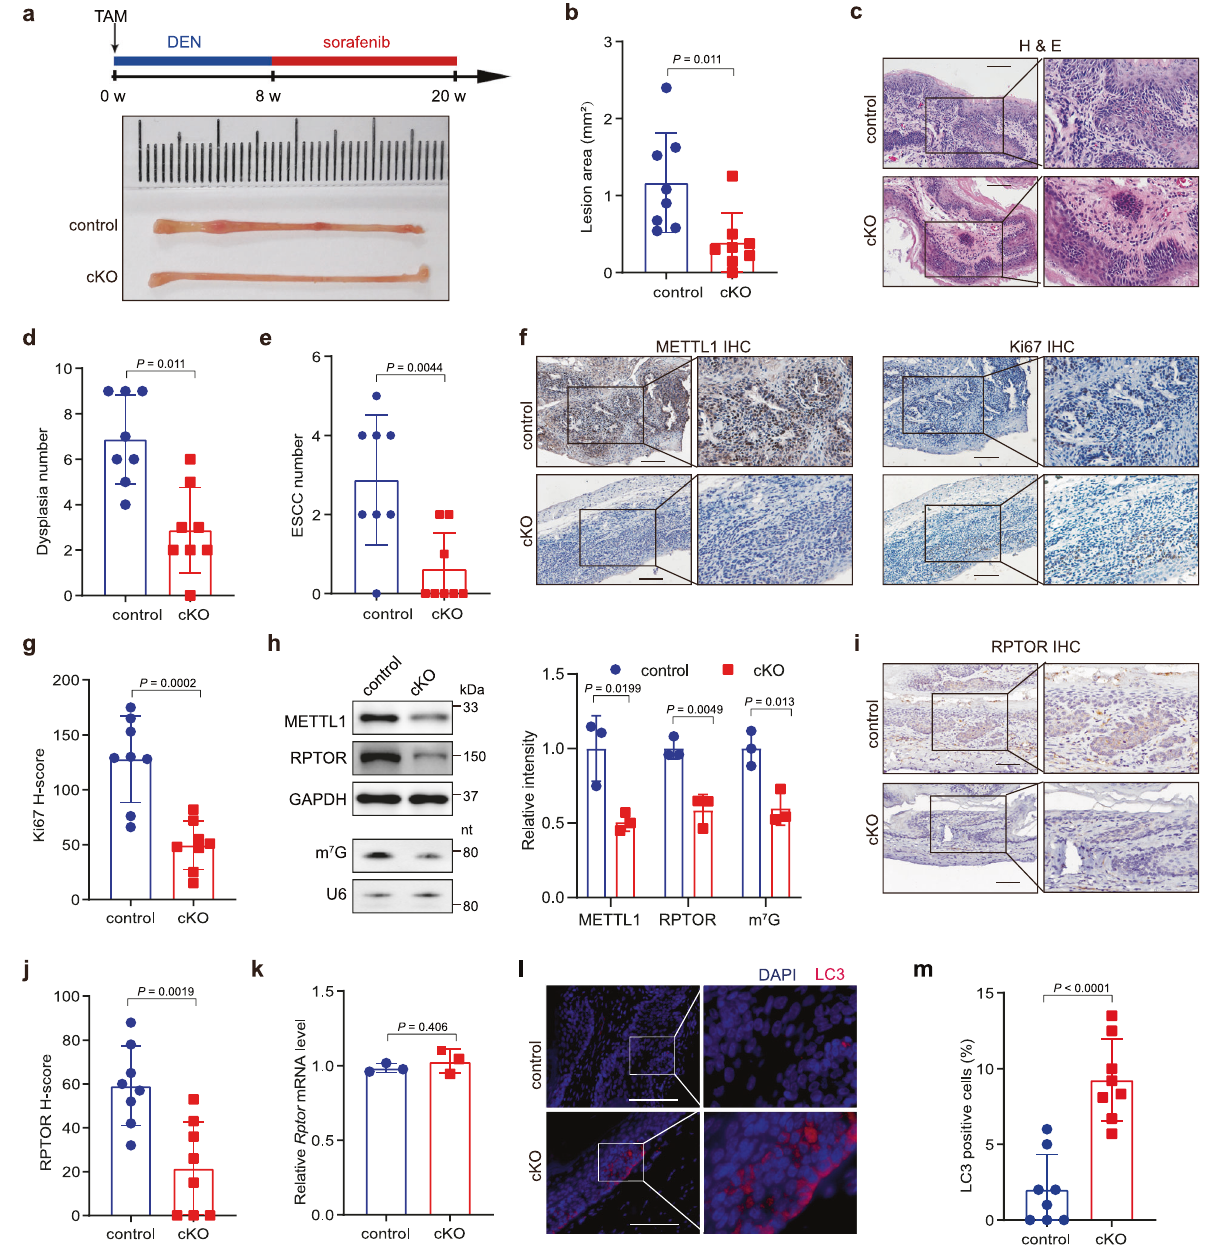
Fig. 5 Knockout of Mettl1 inhibits in vivo ESCC tumorigenesis. a Experimental design for ESCC tumorigenesis model and the representative images of esophageal lesions from Mettl1 cKO and control mice. b Quanti fi cation of lesion areas in Mettl1 cKO and control mice. c Representative H&E staining of esophagus tissues in Mettl1 cKO and control mice. Scale bar, 100 μ m. d Quanti fi cation of dysplasia numbers in Mettl1 cKO and control mice. e Quanti fi cation of ESCC numbers in Mettl1 cKO and control mice. f , g Representative images of METTL1 and Ki67 IHC staining ( f ) and the quanti fi cation of Ki67 H-scores ( g ) in Mettl1 cKO and control mice. Scale bar, 100 μ m. h Western blot analysis and northwestern blot analysis showed the m 7 G modi fi cation level and indicated protein levels, right panel: quanti fi cation of the blot signals, n = 3 biological independent samples for each group. i , j Representative images ( i ) and the quanti fi cation of H-scores ( j ) of RPTOR IHC staining in Mettl1 cKO and control mice. Scale bar, 100 μ m. k qRT-PCR analysis of Rptor mRNA level in cKO and control mice, n = 3 biological independent samples for each group. l , m IF assay ( l ) and the quanti fi cation ( m ) of LC3 levels in Mettl1 cKO and control mice. Scale bar, 100 μ m. Data represented as mean ± SD by two-tailed unpaired Student ’ s t test for all. n = 8 mice for each group for ( a – g , i , j , and l , m